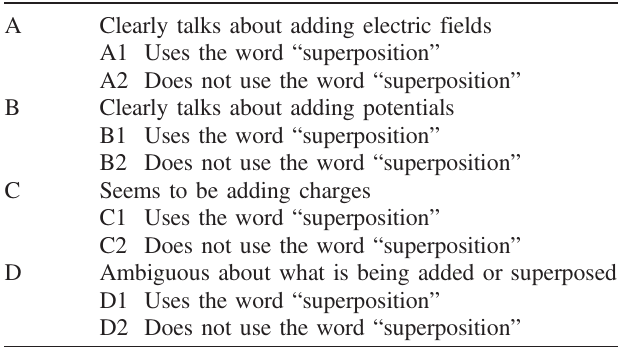
TABLE II. Main categories of responses for our analysis.